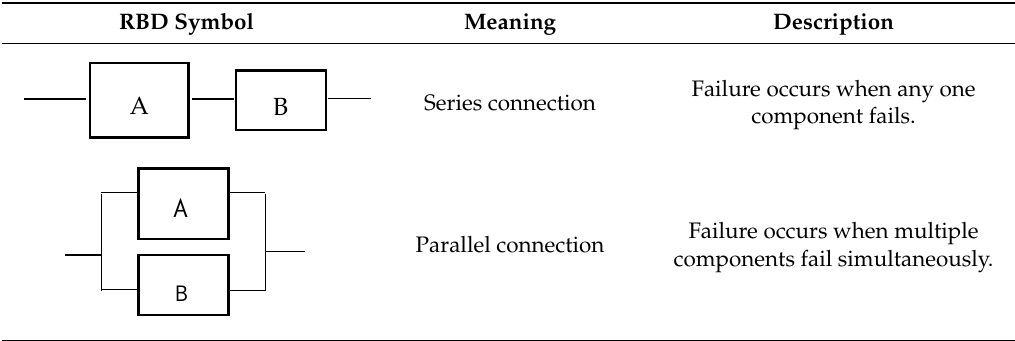
Table 2. Typical reliability block diagram (RBD) symbols and their descriptions. RBD Symbol Meaning Description Series Failure occurs when any one component connection fails.